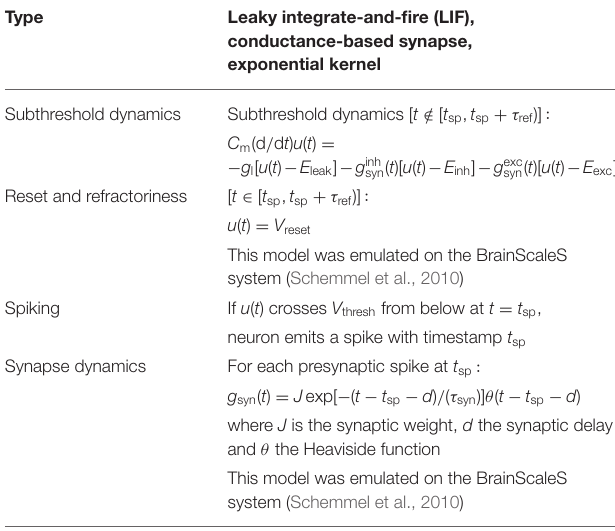
TABLE 1 | Description of the neuron and synapse